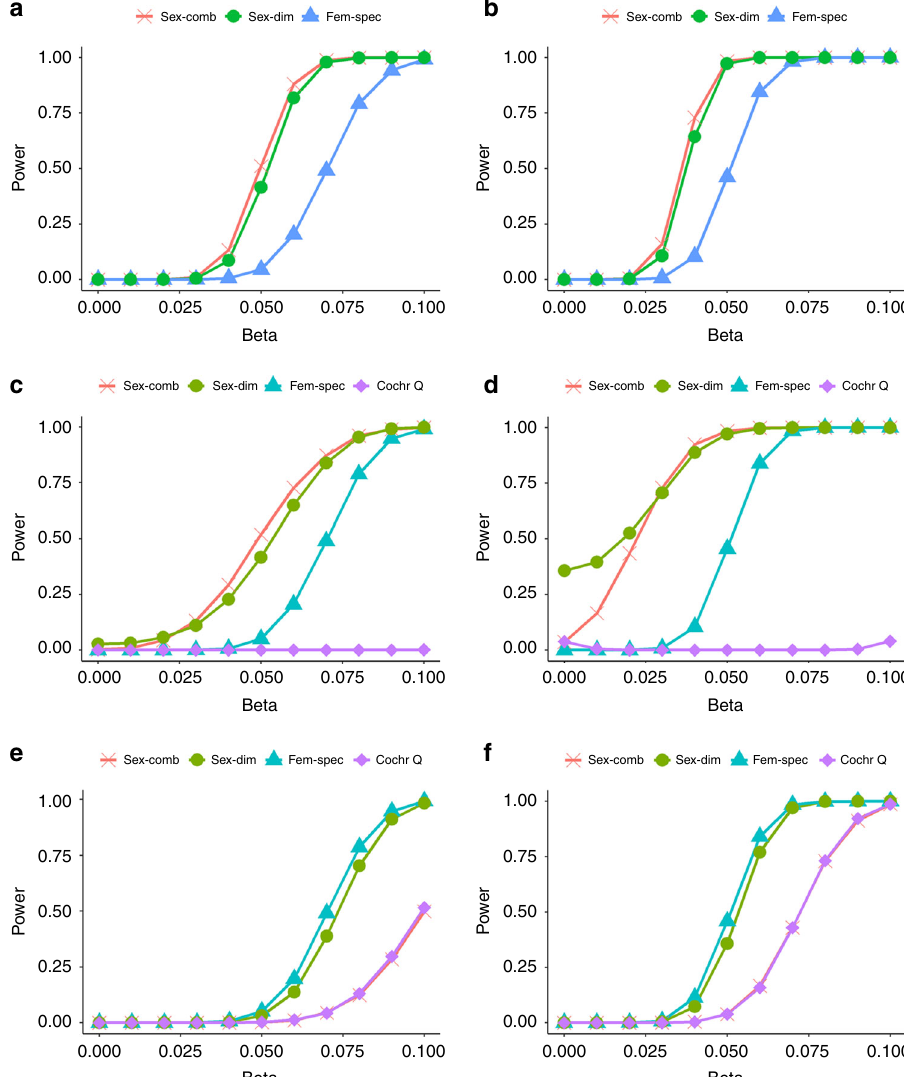
Fig. 4 Power of tests for detecting sex heterogeneity through simulations. The power of sex-combined, sex-dimorphic and female-speci fi c analyses, as well as Cochran ’ s Q -test was evaluated under three scenarios of sex-effects: no sex heterogeneity at a CAF = 0.05 and b CAF = 0.1, effects on both sexes with the presence of heterogeneity between them at c CAF = 0.05 and d CAF = 0.1, an effect speci fi c to one sex only, e.g., women at e CAF = 0.05 and f CAF = 0.1. The power at P < 5 × 10 − 8 is given for all three tests: sex-combined, sex-dimorphic and female-speci fi c. The power for the heterogeneity test implemented in GWAMA (Cochran ’ s Q -test) is also given. Simulations are based on 70,000 men and 70,000 women. For each parameter setting, 10,000 replicates of data were generated. CAF is the causal variant allele frequency and beta is the effect size in SD units in women. Within each scenario, we considered two CAFs (0.05 and 0.1) and a range of betas (from 0 to 0.1) representing the effect size in SD units in women. For the no sex heterogeneity setting, the beta in men is the same as in women; for the sex-dimorphic setting, the beta in men is fi xed at 0.05 SD units; for the female-speci fi c setting, the beta in men is fi xed at